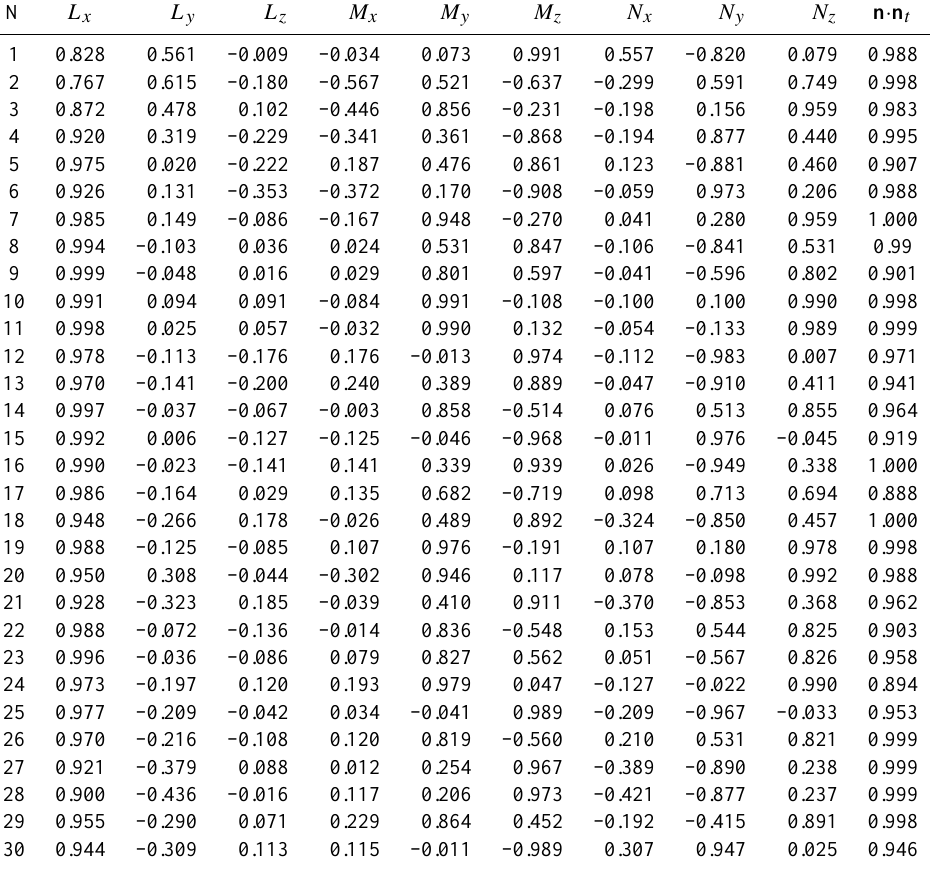
Figure 1 surveys the time series of l , m , n magnetic